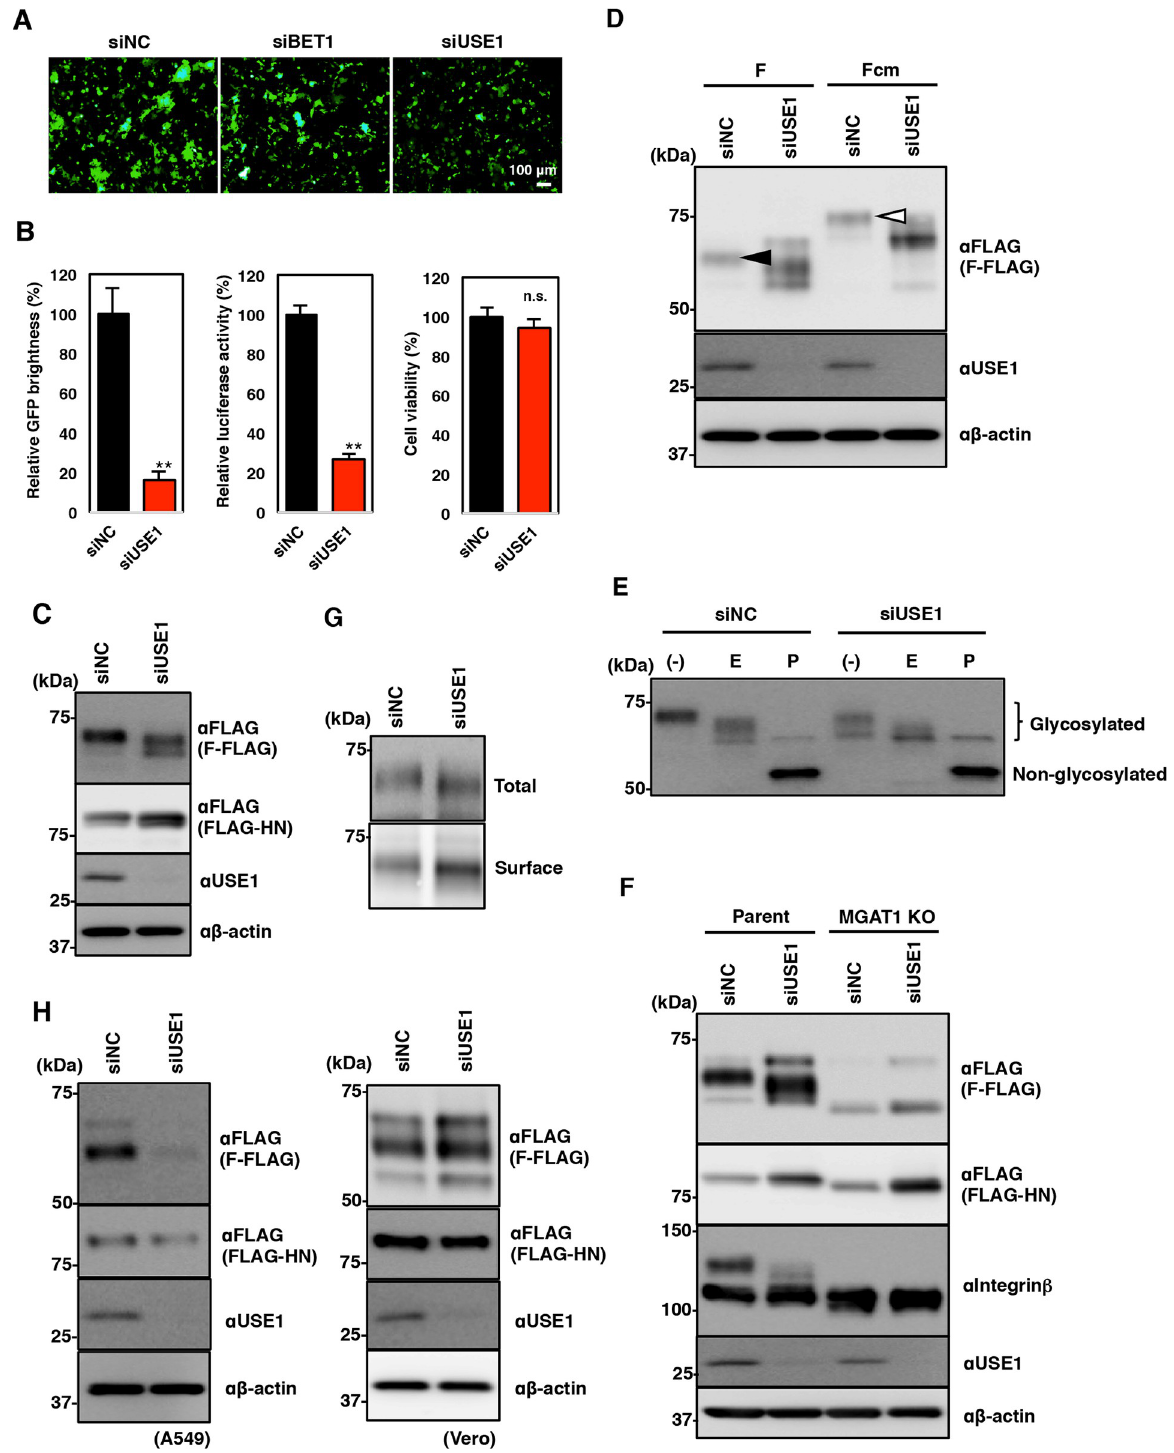
Fig 6. Involvement of USE1 in the glycosylation and expression of MuV F protein. (A) Immunofluorescence assay showing the syncytium formation induced by F and HN proteins in A549 cells transfected with siBET1, siUSE1, or siNC. (B) Relative AcGFP brightness, luciferase activity, and cell viability in USE-knockdown 293CD4/DSP 1–7 and 293FT/DSP 8–11 cells. Error bars indicate the standard deviations of triplicate wells. Differences with a p -value of < 0.01( �� ) were considered to be statistically significant. (n.s. = not significant) (C) Immunoblotting showing the expression levels of F-FLAG, FLAG-HN, USE1, and β -actin in 293T cells transfected with siUSE1 or siNC. (D) Immunoblotting showing the